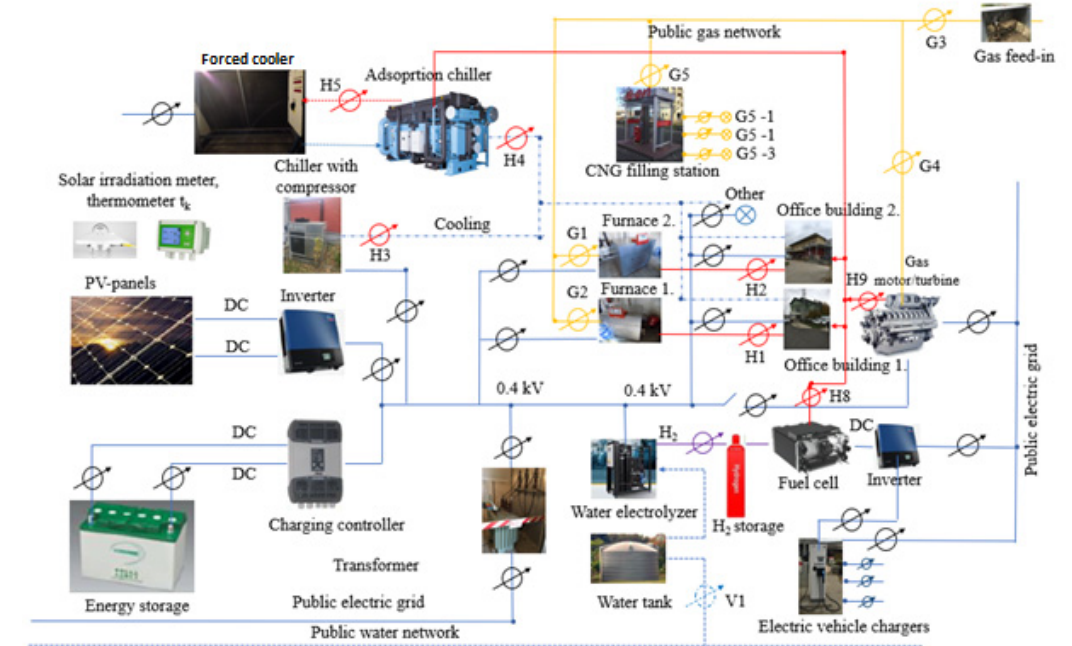
Figure 4. A possible distribution of metering points.